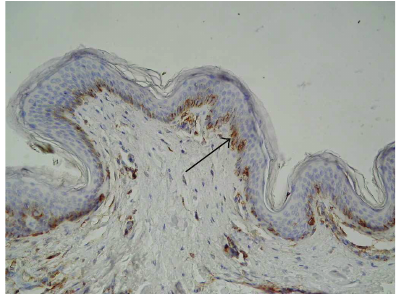
Figure 4: Skin lesions in BP, immunohistochemistry. Moderate ex- pression of β 4 integrin in the dermal part of blister and in blister fluid (original magnification